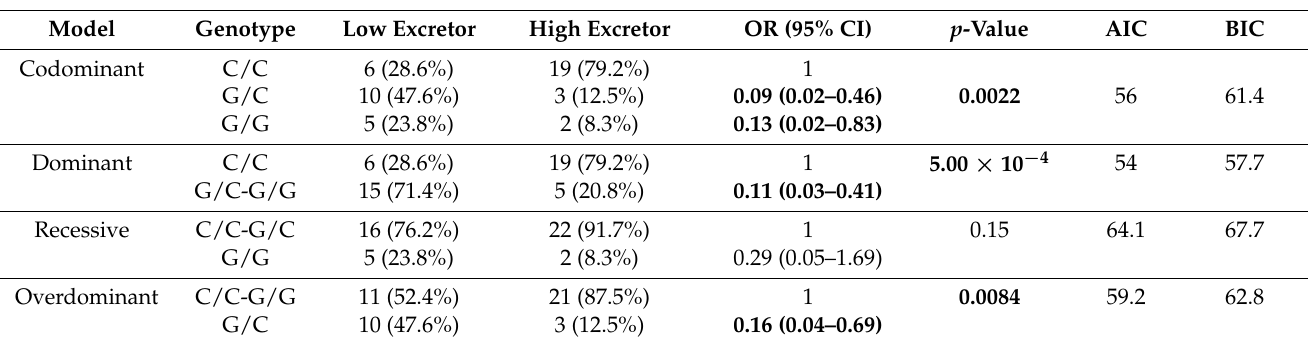
Table 9. Genotypes and allele frequencies of SULT1A1_rs1402467 polymorphism in studied population.